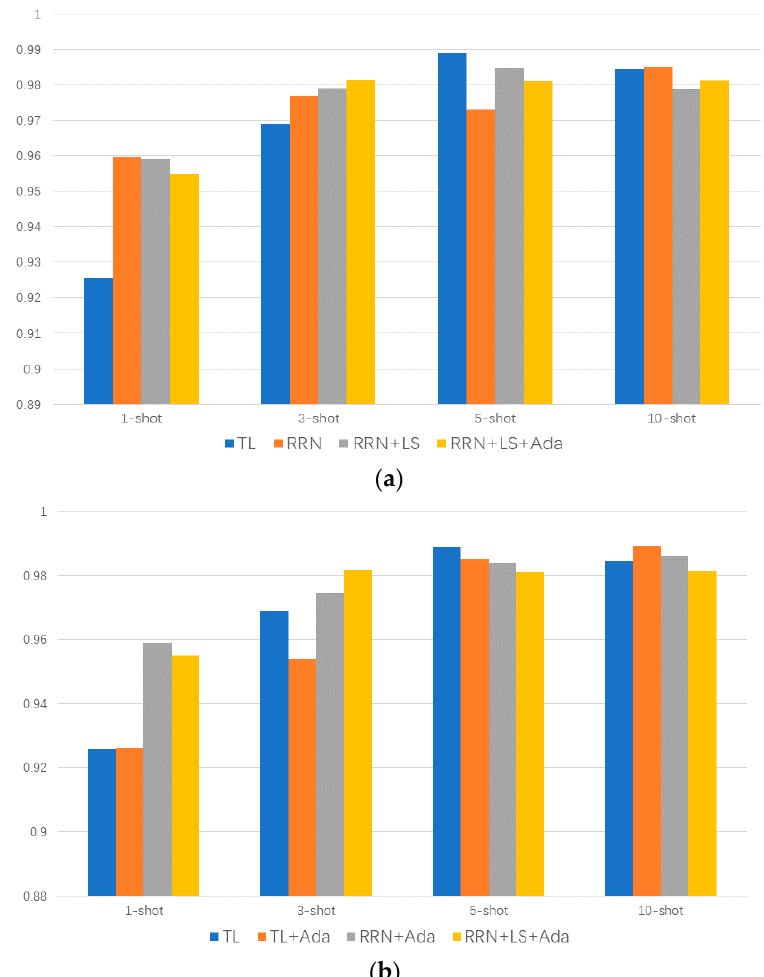
Figure 9. Effect of label smoothing and Adabound on model accuracy. ( a ) represents the comparison of the result accuracy of TL, RRN, RRN with LS, and RRN with LS and Ada, ( b ) represents the comparison of the result accuracy of TL, TL with Ada, RRN with Ada, and RRN with LS and Ada.